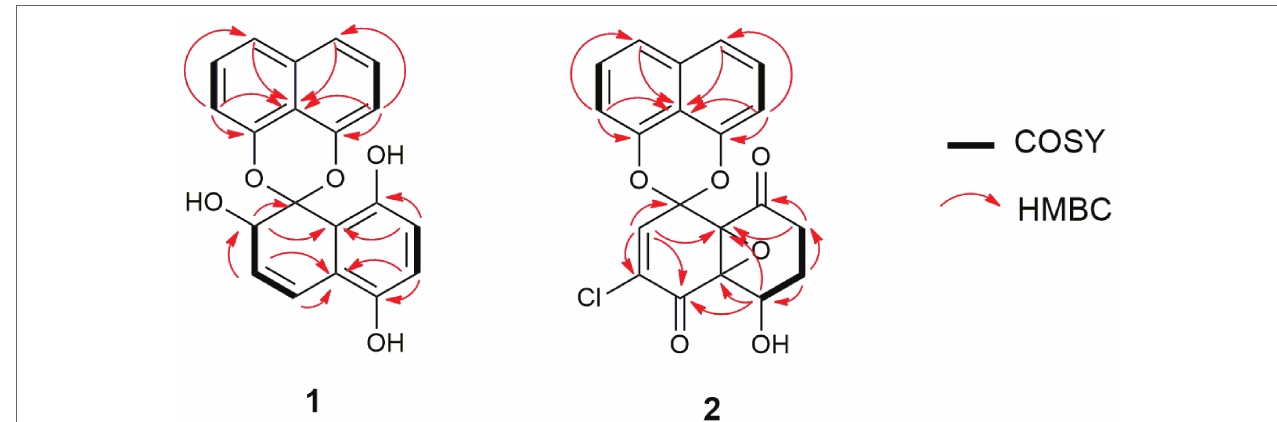
FIGURE 7 | Selected COSY and HMBC correlations of palmarumycin CP 30 ( 1 ) and palmarumycin C 8 ( 2